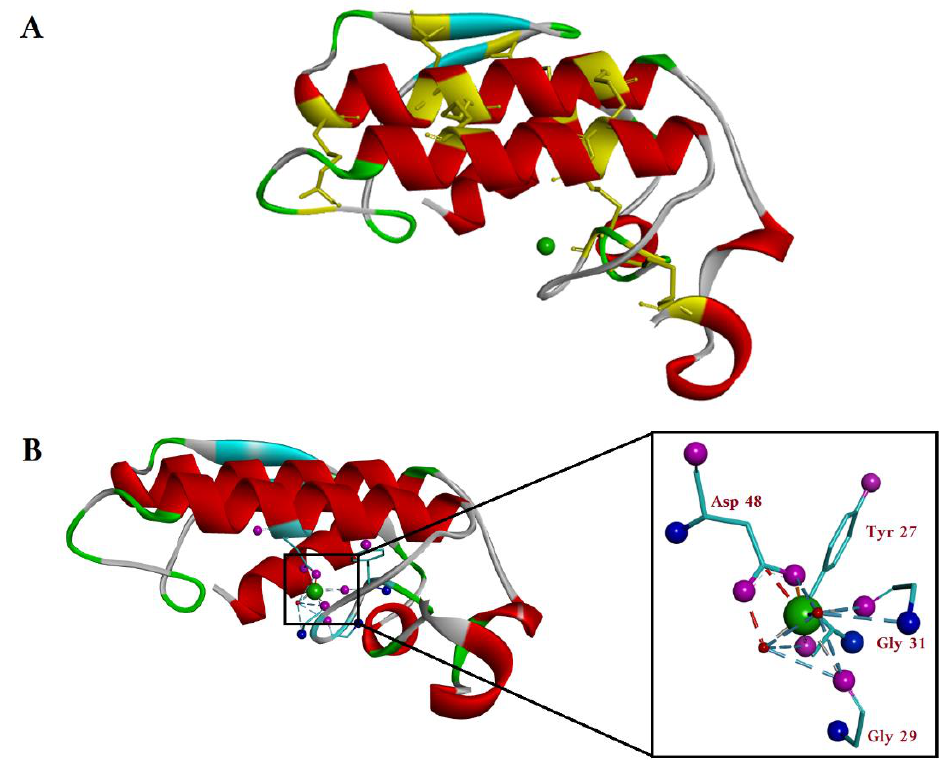
Figure 3. ( A ) Top view of the crystal structure of G-IA sPLA2 ( Naja naja ) (PDB-1PSH). The α -helices and β -sheets are shown in red and light blue. The cysteines forming the seven disulfide bonds are shown in yellow, also marking in yellow their position on the protein backbone. The calcium ion is shown as a green sphere in the enzyme active site. ( B ) Side view of the crystal structure of the sPLA2 with the Ca 2+ coordination shown in detail in the zoomed insert. The oxygen atoms and the nitrogen atoms of the amino acids coordinated with Ca 2+ (green sphere) are colored pink and blue, respectively. The Ca 2+ is directly coordinated with carboxy group from Asp48 of one α -helix and by the C=O backbone groups of Tyr27, Gly29 and Gly31 from the opposite loop. (Image generated using BIOVIA Discovery studio.)